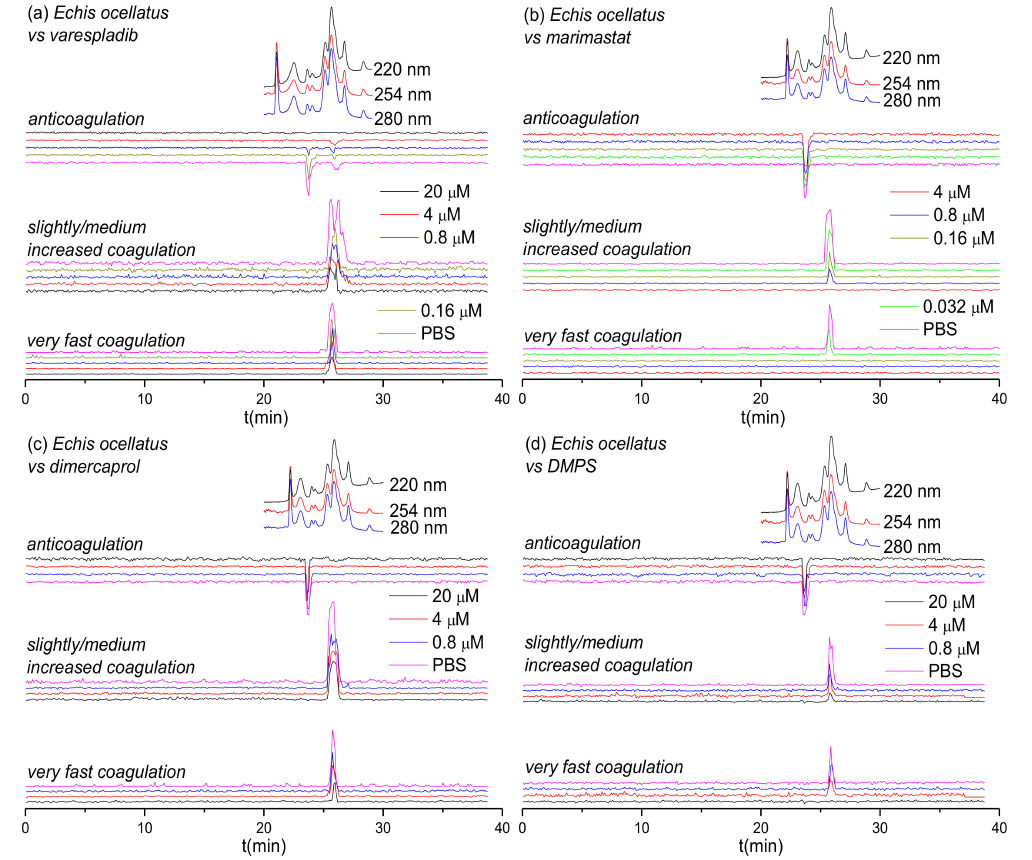
Figure 2. UV absorbance chromatograms reconstructed coagulopathic toxicity chromatograms of nanofractionated toxins from E. ocellatus venom in the presence of di ff erent concentrations of ( a ) varespladib, ( b ) marimastat, ( c ) dimercaprol and ( d )